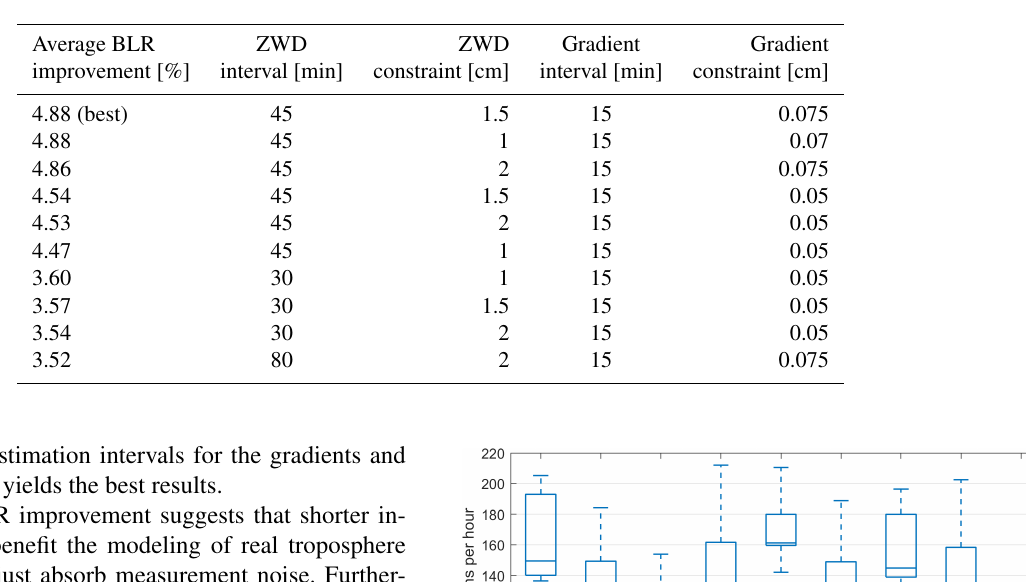
Table 4. The ten best performing troposphere parametrizations out of the 225 tested parametrizations along with the resulting average BLR improvement.